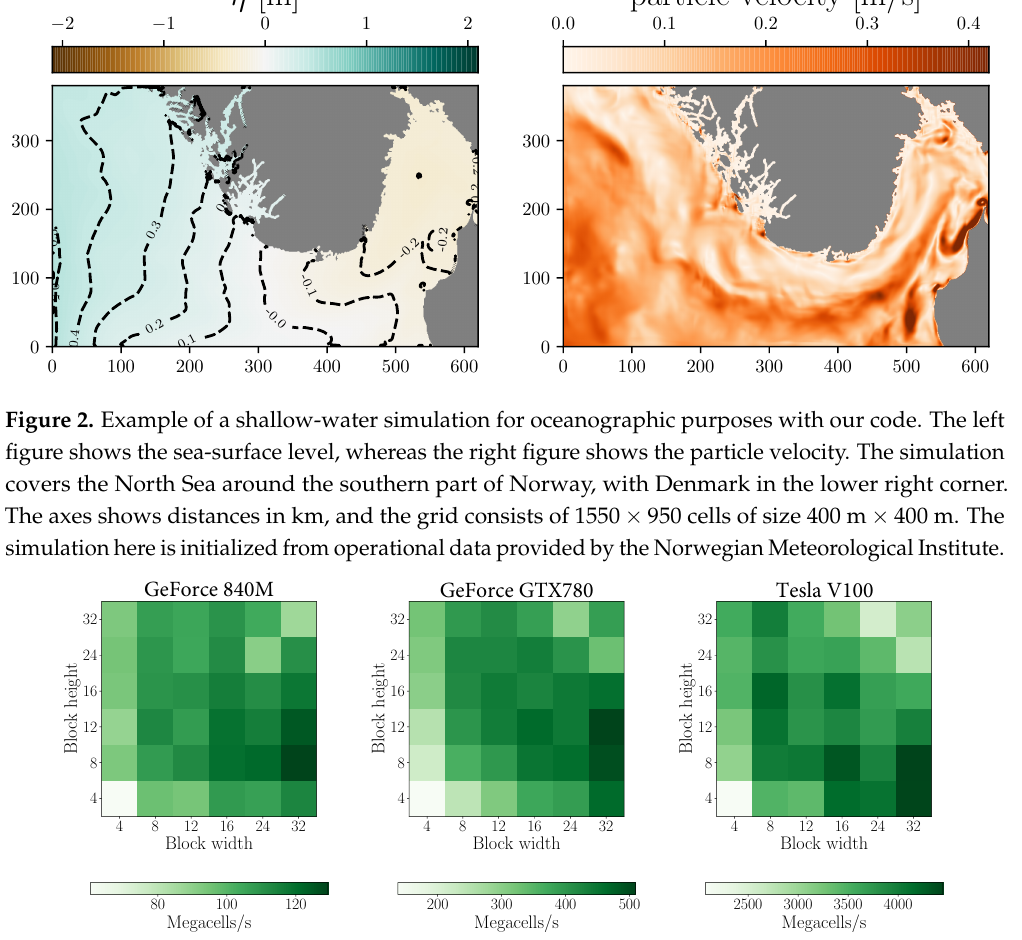
Figure 3. Heat map of performance as a function of block width and block height for selected sizes for the high-resolution scheme on three different GPUs. Notice that even though the performance patterns have similarities, the performance on the V100 would be suboptimal if the optimal configuration from the GTX780 is used. The performance increase is 2–5 for all three GPUs from the slowest to the fastest × block